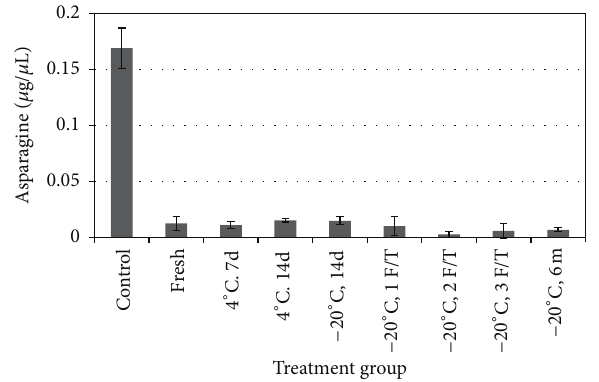
Figure 5: Effect of cold storage on asparaginase enzyme activity. There is no significant difference between types of cold storage on asparaginase activity, 𝑃 = 0.0637 .